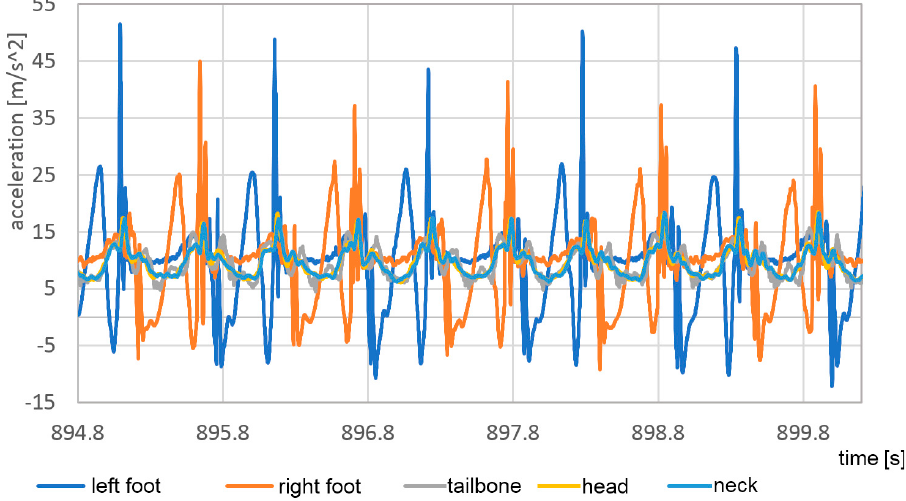
Figure 26. Vertical component of acceleration of each sensor during the passage in sport shoes.